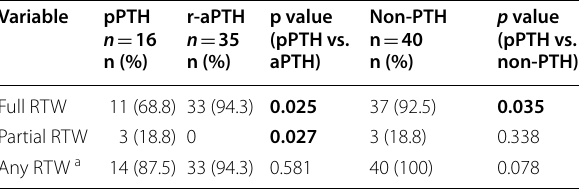
Dichotomous variables: Pearson Chi–square test a Including both full- and partial RTW r-aPTH recovered acute post-traumatic headache; pPTH persistent post- traumatic headache; RTW return to